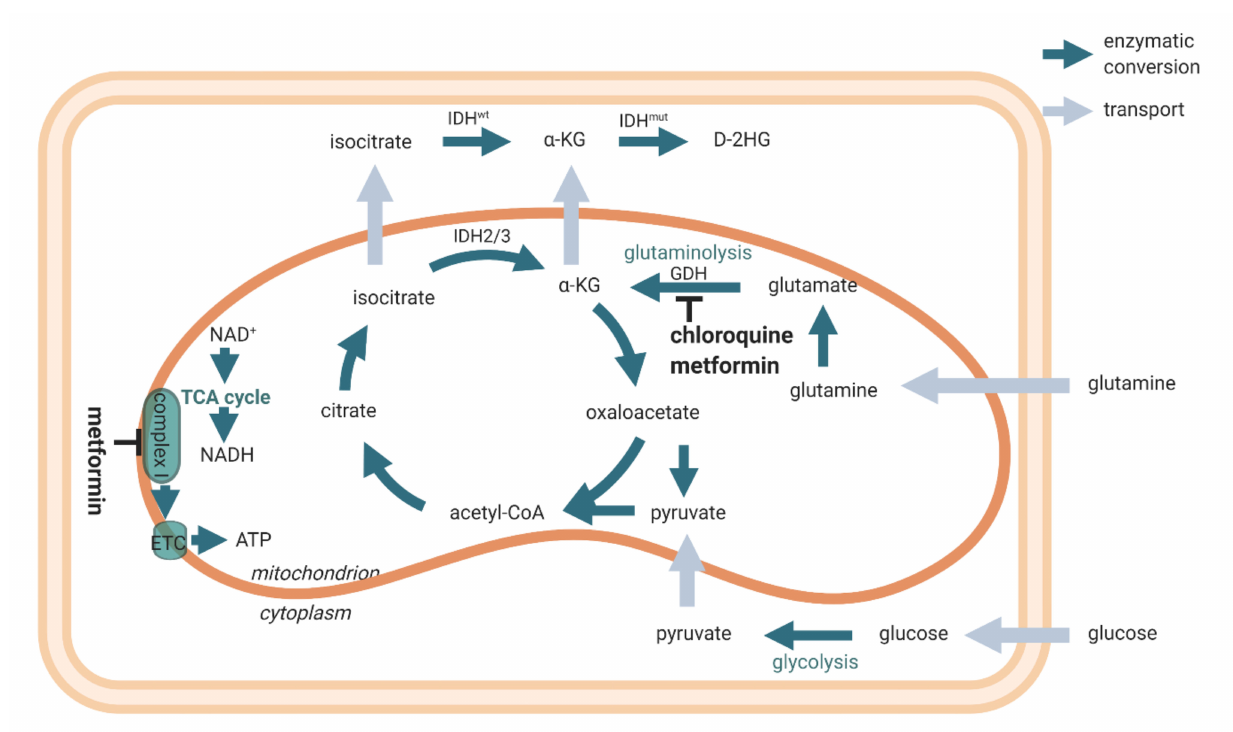
Figure 5. Scheme of cellular energy metabolism (ATP production) and the inhibitory actions of metformin and chloroquine. Reprinted with permission